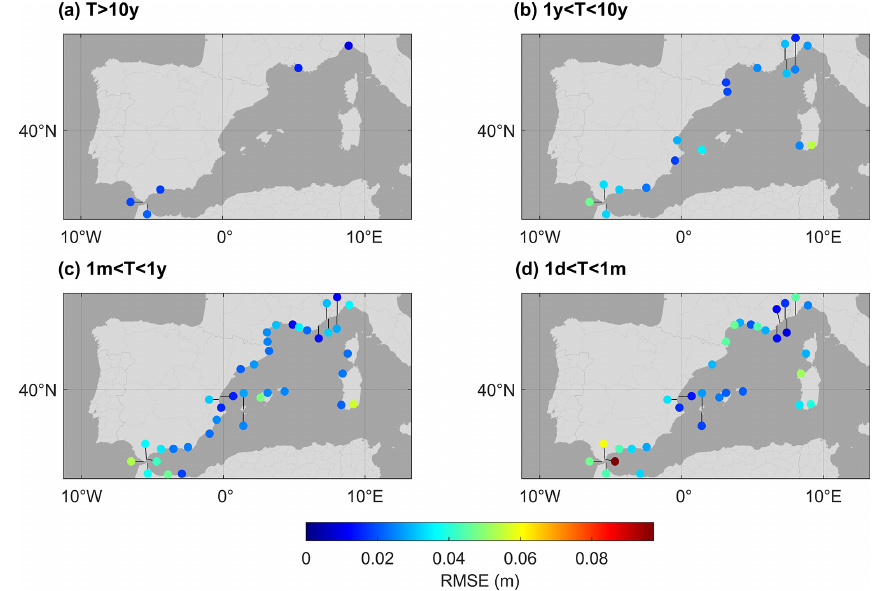
Figure 2. The rms differences between the reconstructed values and the original series for the four frequency bands: (a) T > 10 y , (b)